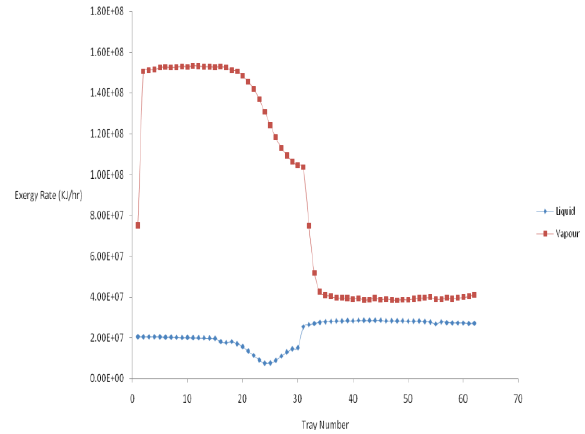
Figure 21. Profile of exergy rate versus tray number for Depropanizer of base case, Reflux Ratio 2